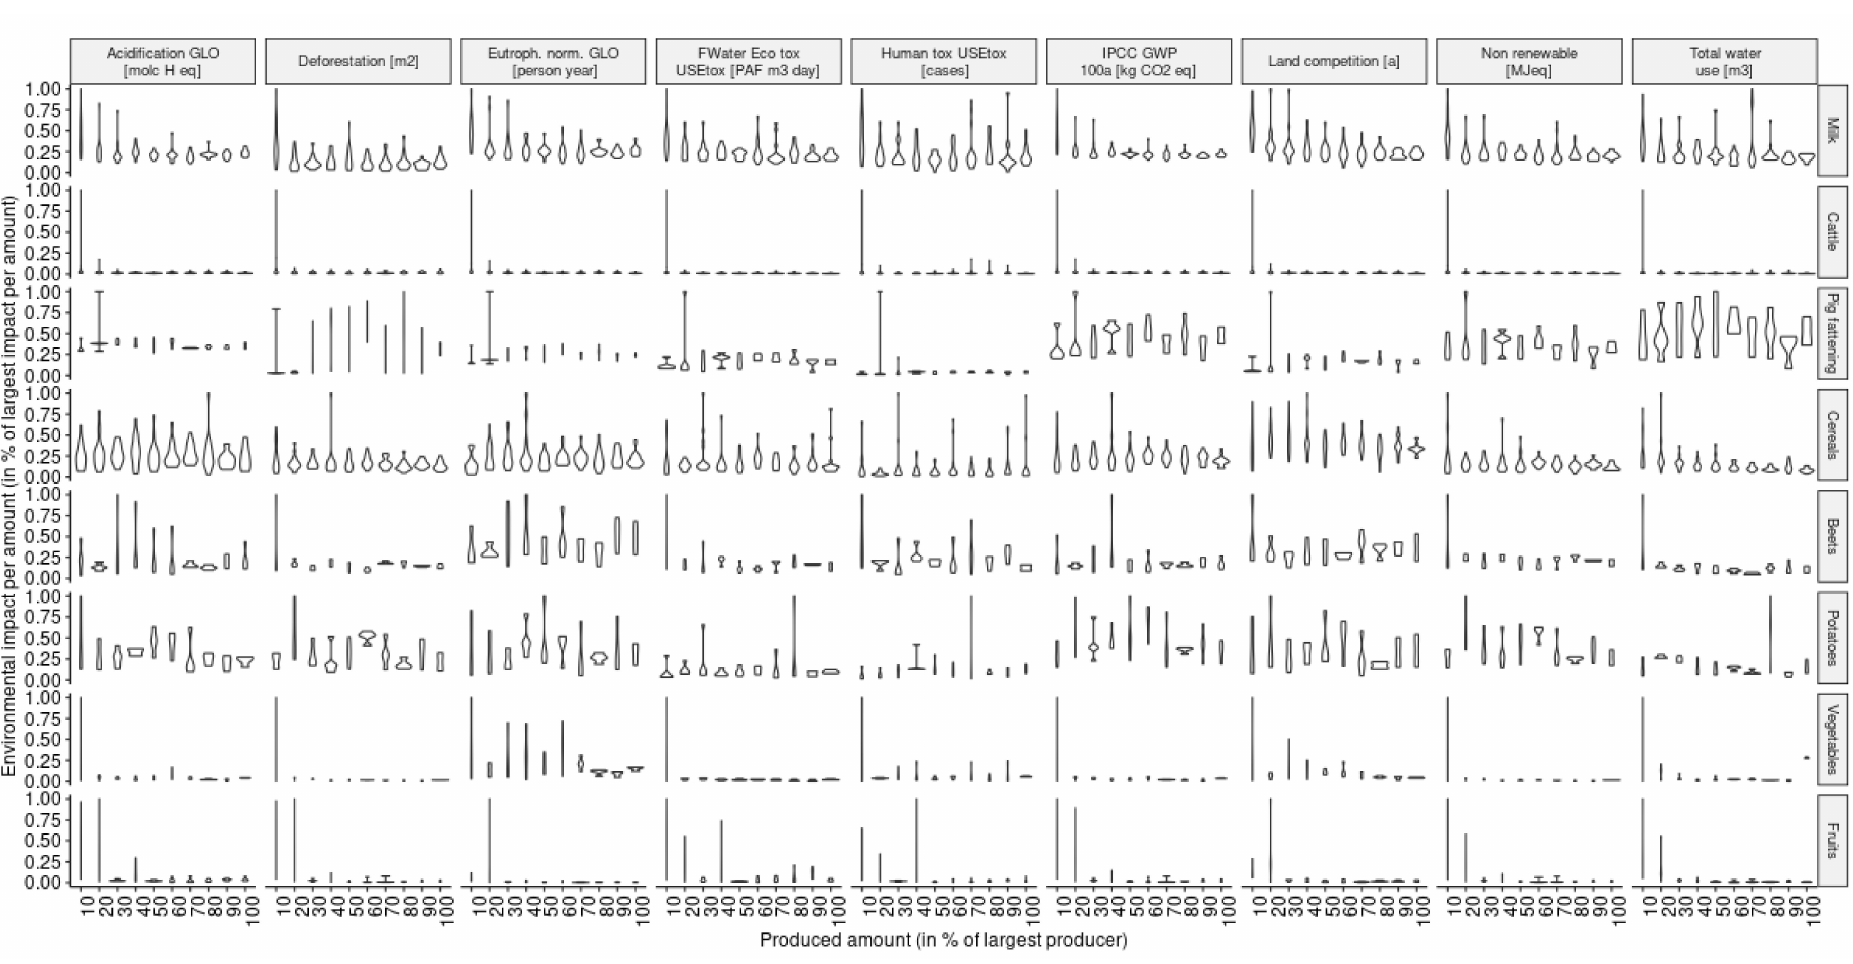
Figure A3. Variance in environmental efficiency estimate vs. product group size (measured as output). Smaller product groups show larger variance in estimates. (PAF m 3 day = potentially affected fraction of species integrated over time and volume, eq = equivalent, MJ =